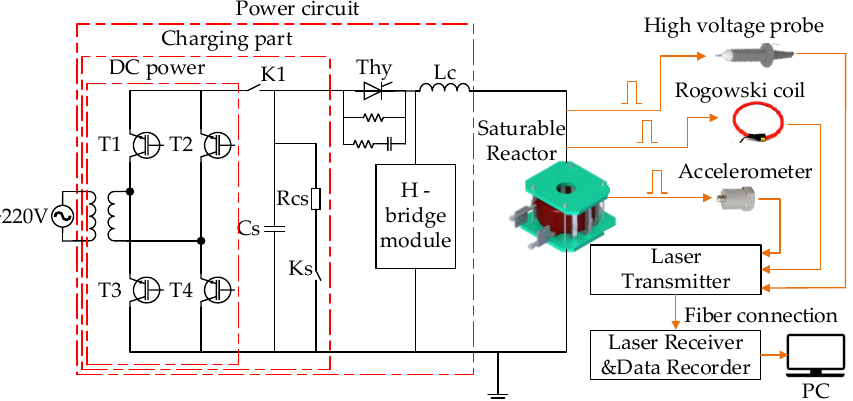
Figure 6. Wiring diagram of the saturable reactor vibration experiment.